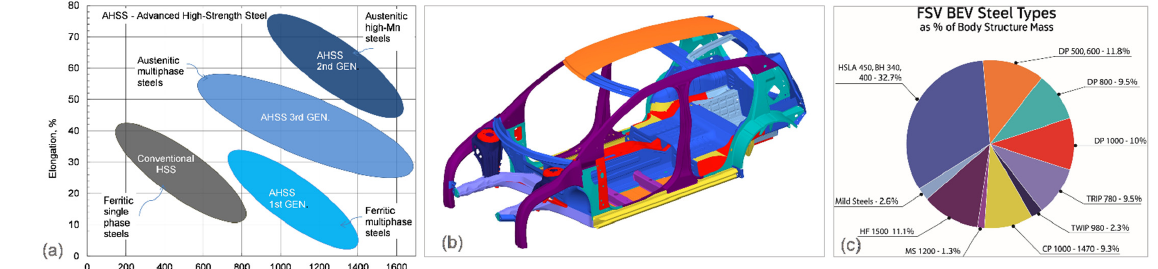
Figure 10. AHSS steels in electric vehicles: ( a ) schematics of formability–strength relationships in AHSS and ( b , c ) contribution of various steel grades to battery electric vehicles developed within the Future Steel Vehicle (FSV) program with 95% HSLA and AHSS, and with 48% having a strength over 1000 MPa, according to the World Steel Association [46].